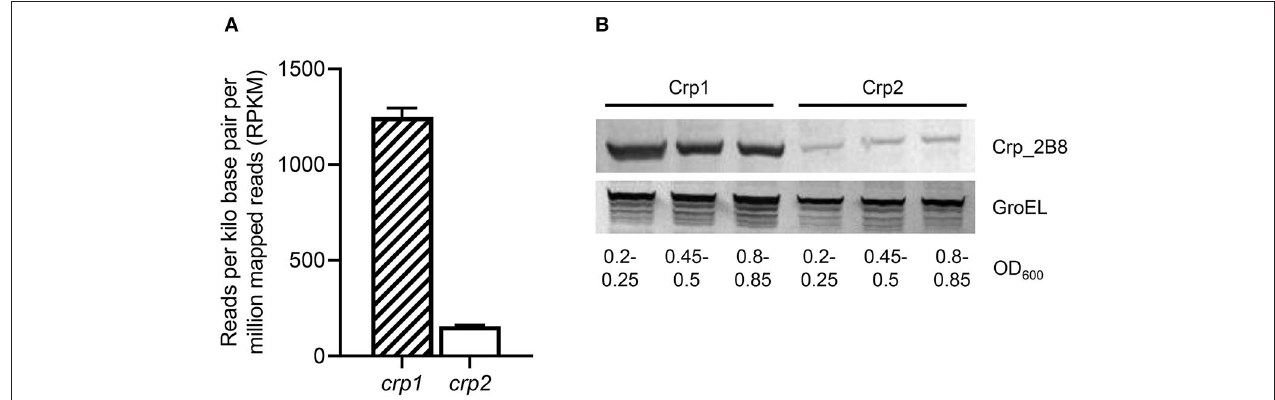
FIGURE 3 | Expression levels of two Crp paralogs in M. smegmatis . (A) Transcript levels of crp1 and crp2 were extrapolated from the RPKM values obtained from RNA sequencing analysis on the WT strain of M. smegmatis (Lee et al., 2018). (B) Expressed protein levels of Crp1 and Crp2. To determine the protein levels of Crp1 and Crp2 expressed in M. smegmatis , the 1 crp1 and 1 crp2 mutant strains complemented with pMV306crp1_2B8 and pMV306crp2_2B8, respectively, were grown aerobically to the indicated OD 600 in 7H9-glucose medium, and their crude extracts (30 µ g for detection of Crp1 and Crp2; 5 µ g for GroEL detection) were subjected to Western blotting analyses using a 2B8 antibody and an Hsp65 antibody to detect the C-terminally 2B8-tagged Crp and GroEL, respectively. The protein level of GroEL was determined as a loading control.